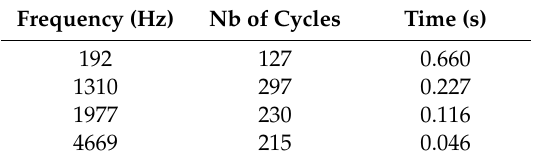
Table 1. Number of cycles and time to reach steady-state